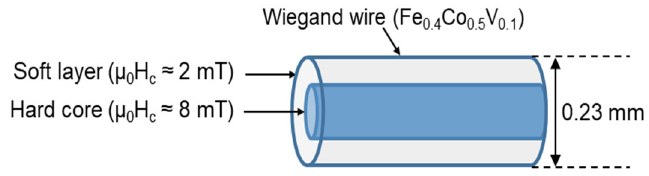
Figure 1. Magnetic structure of Wiegand wire.